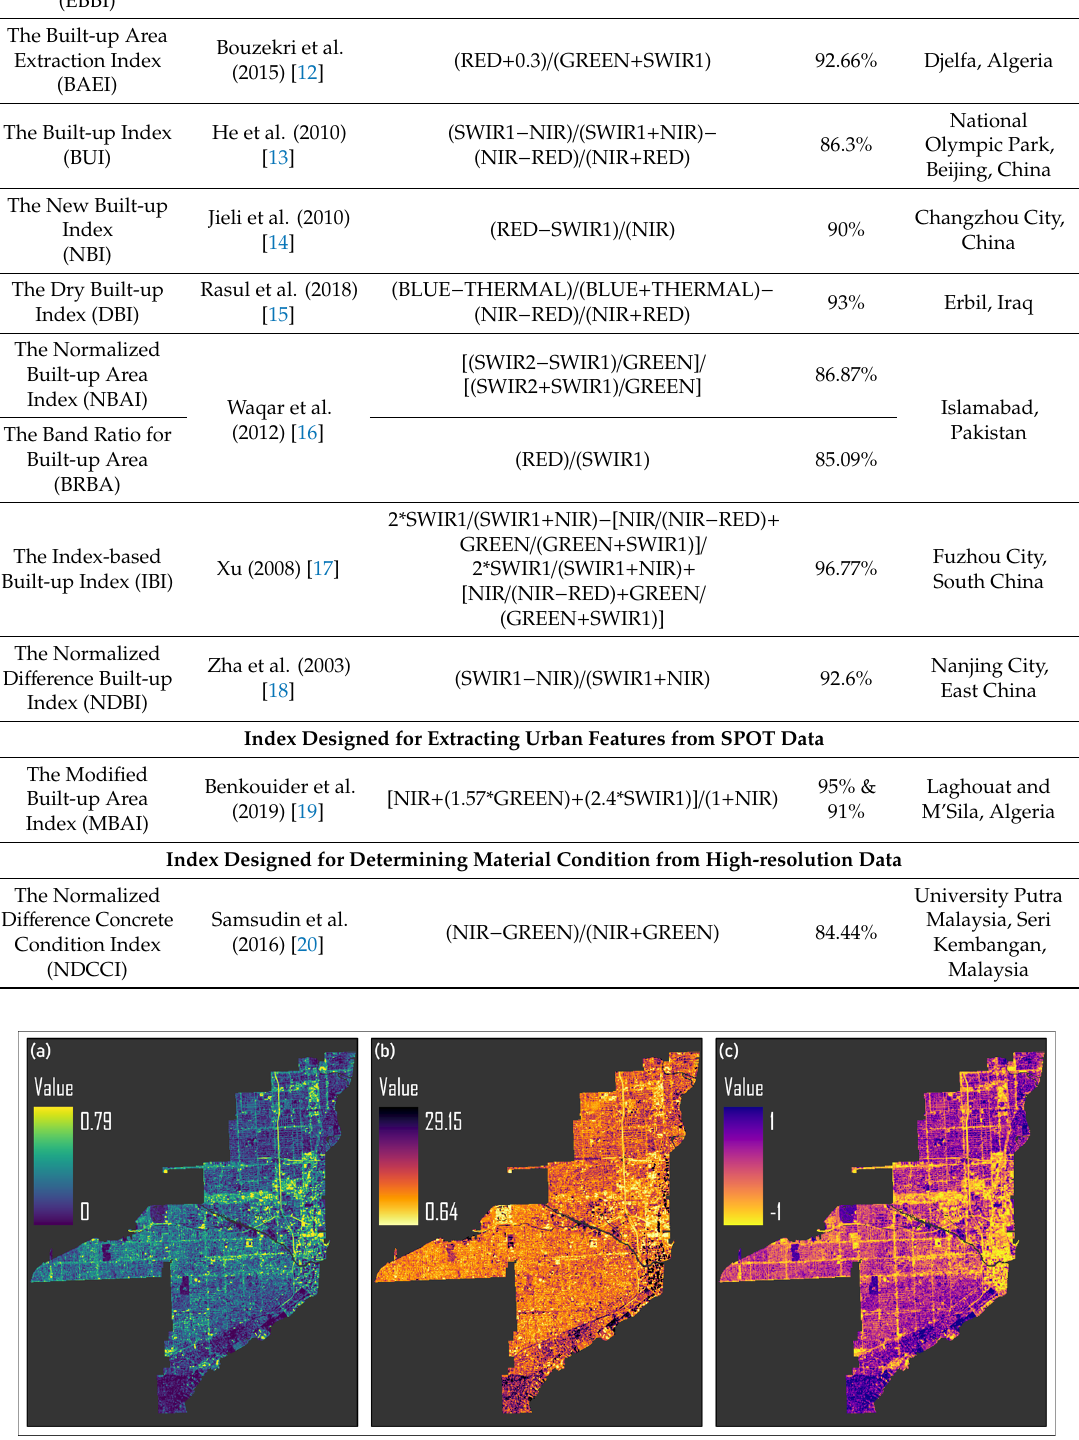
Table 2. Built-up indices found in scientific journals evaluated for unique spectral properties.